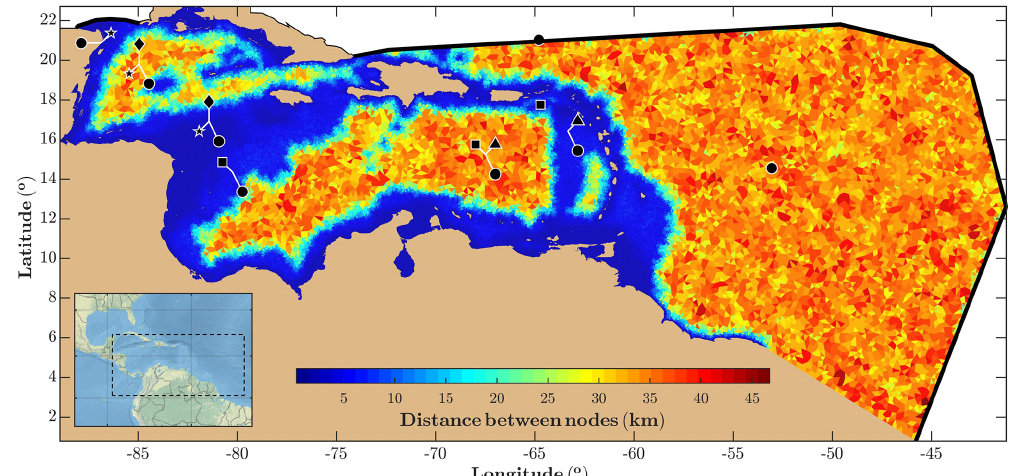
Figure 2. Domain of simulation (with the inset indicating the global region) and the computational grid. The colours represent the distance between nodes in the computational grid, with the spatial resolution varying with depth. Thick black lines represent the open boundaries of the model domain. Black markers represent the location of buoys and tide gauges used for the validation, with the shape indicating the corresponding TC, as in Table 1. In some cases, the same instrument is used for various cases, with the exact position denoted by white